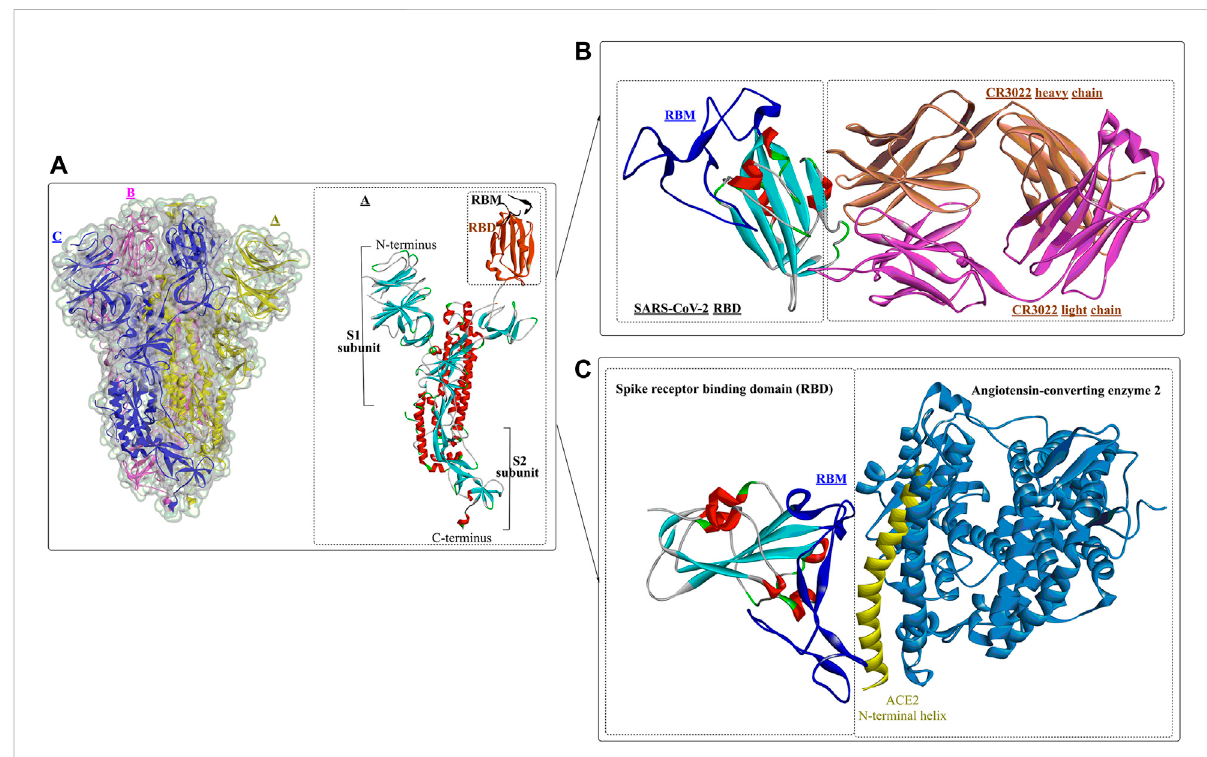
FIGURE 2 Crystal structure of prefusion SARS-CoV-2 spike glycoprotein (1, PDB ID: 6VSB), antibody CR3022 binding to the SARS-CoV-2 RBD (2, PDB ID: 6W41), and the SARS-CoV-2 spike receptor-binding domain bound with ACE2 (3, PDB ID: